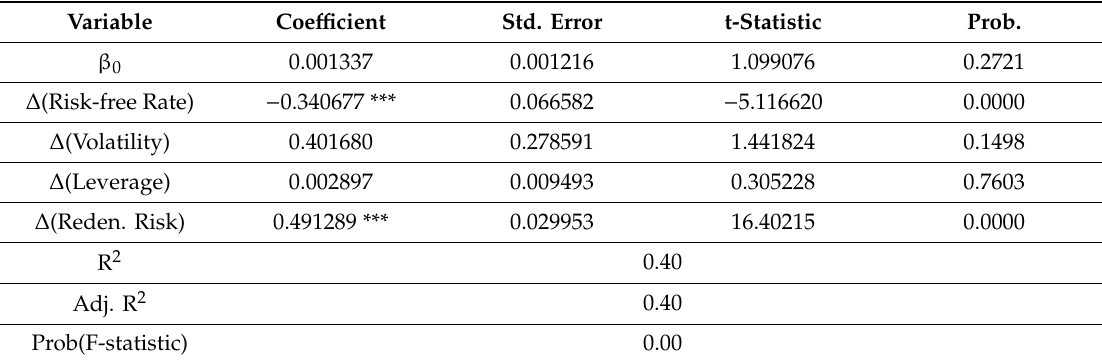
Table 4. OLS estimates: period October 2009–July 2012 (723 Obs.).